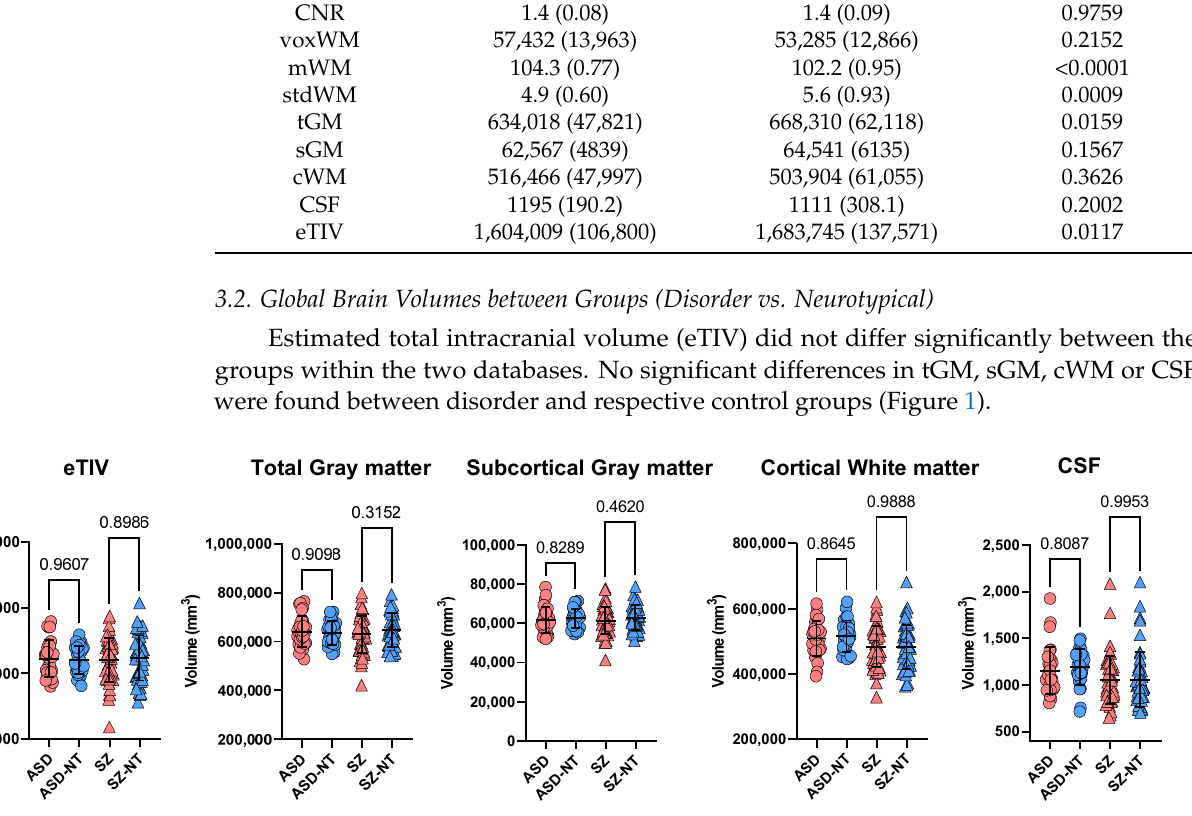
Figure 1. Mean ± standard deviation for non-normalized volumetric measures (in mm 3 ) of total gray matter, subcortical gray matter, cortical white matter and CSF for the disorder groups and their respective neurotypical groups (ASD [ n = 29] and ASD-NT [ n = 29]; SZ [ n = 51] and SZ-NT [ n = 51]). Statistical significance of group differences is indicated numerically. Red circle: ASD, blue circle: ASD-NT, red triangle: SZ, blue triangle: SZ-NT.